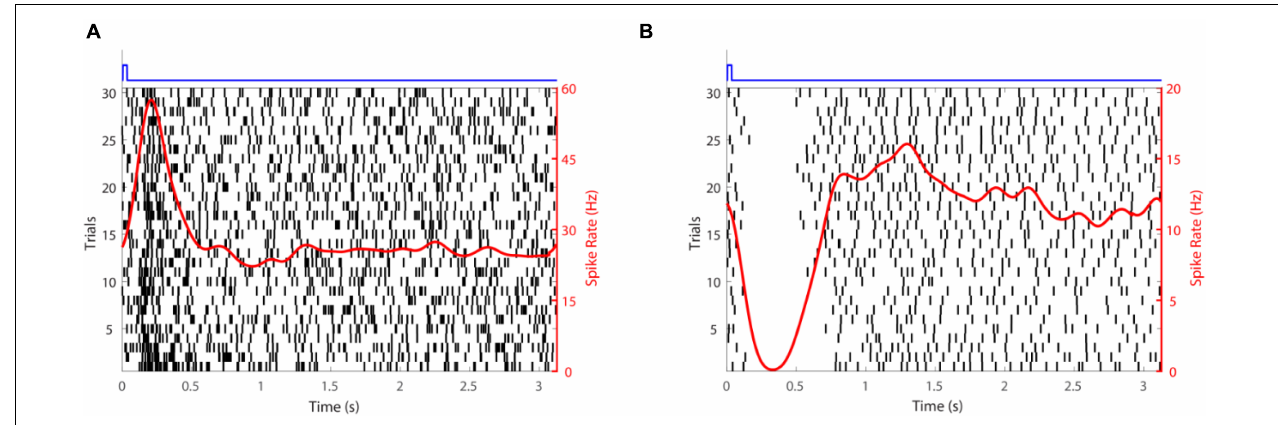
FIGURE 2 | Retinal ganglion cell responses to glutamate stimulation. (A) An excitatory response. (B) An inhibitory response. The time-course of glutamate delivery is indicated by the blue stimulus traces shown at the top. Thirty trials (left axis) are shown for each cell. Action potentials discharged are indicated by vertical lines and the spike rate (right axis) averaged across trials (a smoothed peri-stimulus time histogram) is given by the red line.